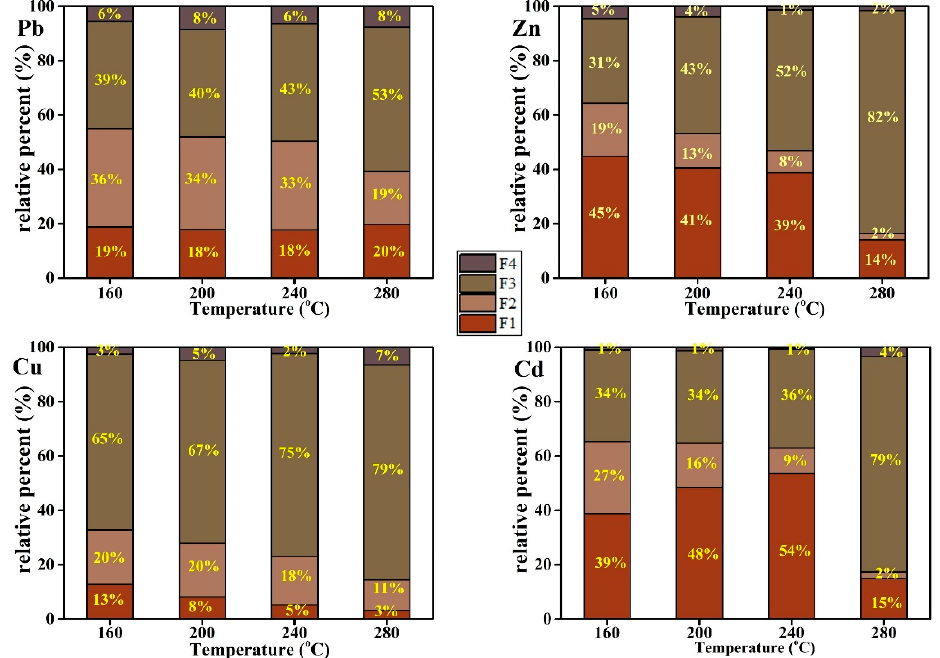
Figure 4. The relative percentages (% of total) of heavy metals (Pb), (Zn), (Cu), (Cd) existing in F1, F2, F3 and F4 in hydrochars with different temperature.